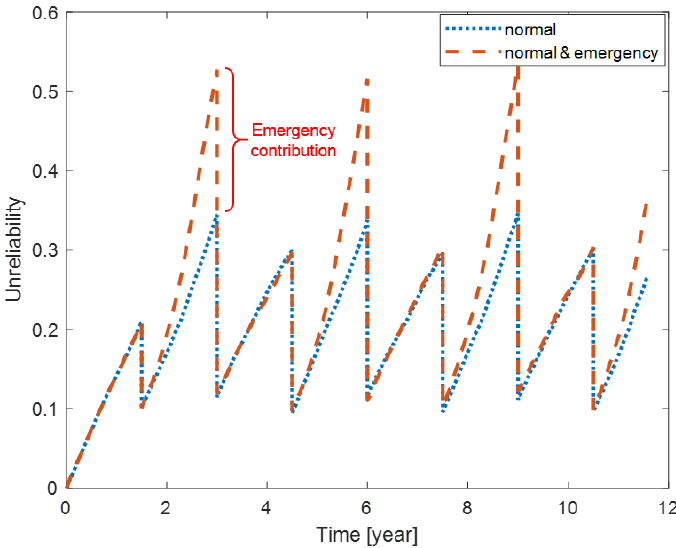
Figure 12. Results comparison between normal and emergency